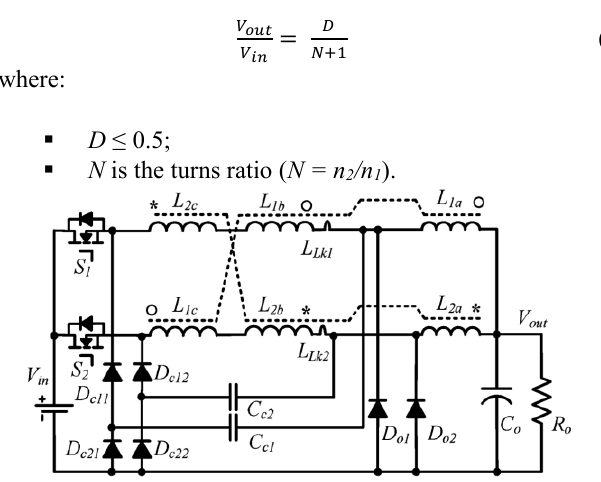
Fig. 9. Interleaved DC – DC high step-down buck converter with winding-cross- coupled inductors (WCCIs) and passive-lossless clamp scheme